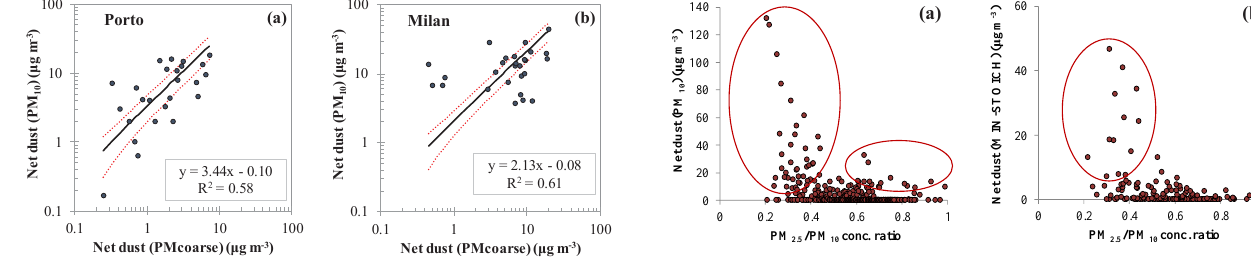
Figure 9. Deming regression analysis of net dust concentrations cal- culated from regional background PM 10 and PMcoarse (PM 2 . 5 − 10 ) concentrations for Porto (left) and Milan (right). The black line cor- responds to the linear regression equation, while the red dotted lines are the upper and lower bounds, at the 95% confidence interval.